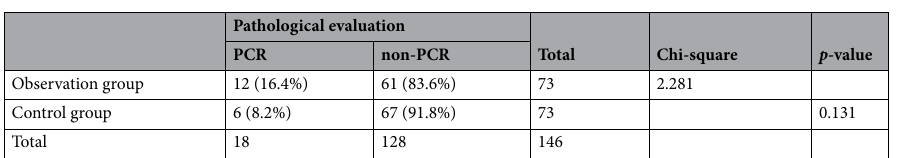
Table 3. Postoperative pathological evaluation (unit: case). PCR pathological complete response, non-PCR not pathological complete response.